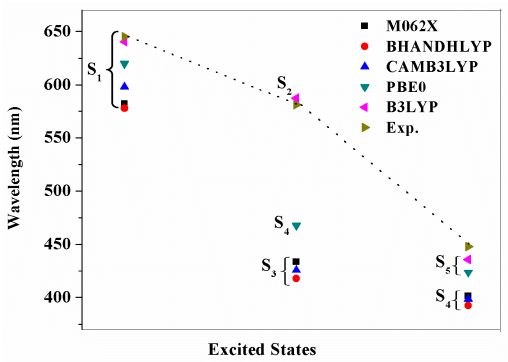
Figure 4. The absorption spectrum (nm) for of YD2-o-C8 obtained by M062X, BHANDHLYP, CAMB3LYP, PBE0, and B3LYP in combination with the polarized continuum model (PCM) in tetraHydroFuran (THF) medium, together with the experimental values [14].